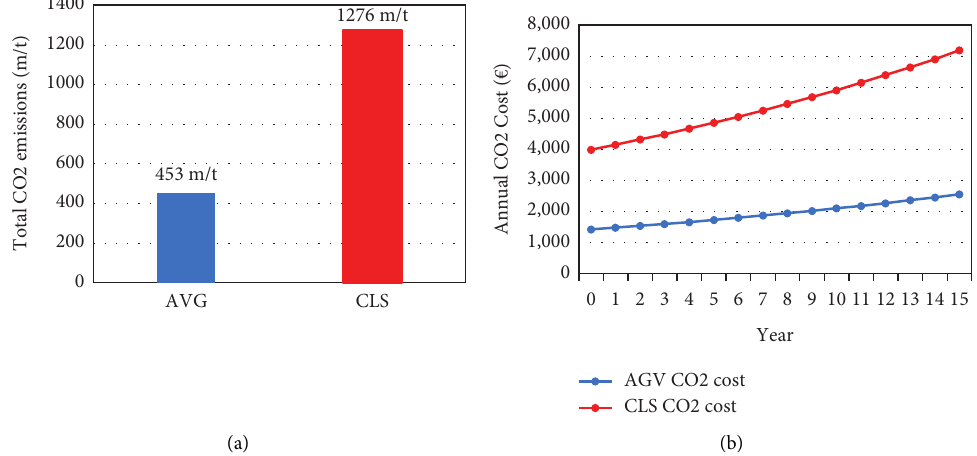
Figure 7: (a) Total CO 2 emissions from the current and AGV loading systems for a 15-year period and (b) CO 2 emission costs of the current and AGV loading systems each year (source: